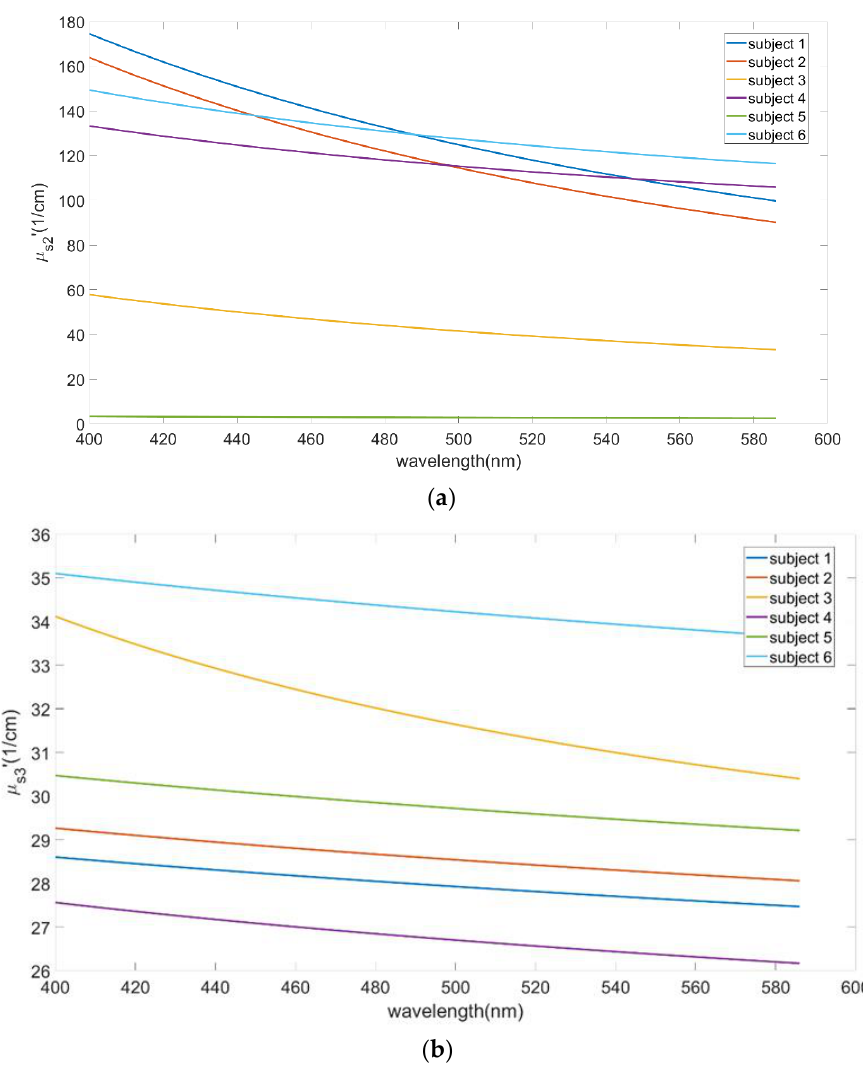
Figure 8. Extracted ( a ) μ s2 ’ ( b ) μ s3 ’ of in-vivo inner forearm skin of healthy volunteers.